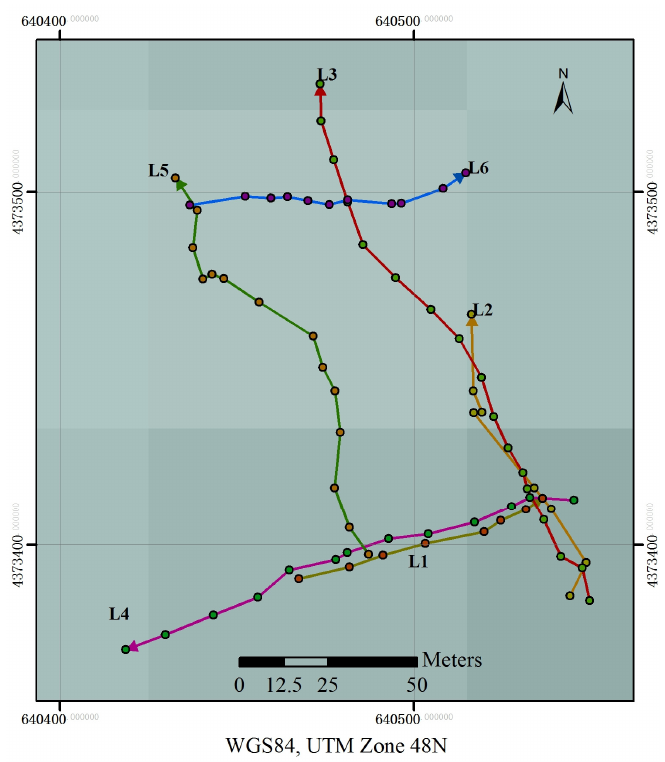
Figure 8. Spatial arrangement of six temperature-sampling transects measured on 27 March 2013 (L1 and L2) and on 22 June 2013 (L3, L4, L5 and L6). Circles are measurement locations. ASTER TIR pixels are shown in the